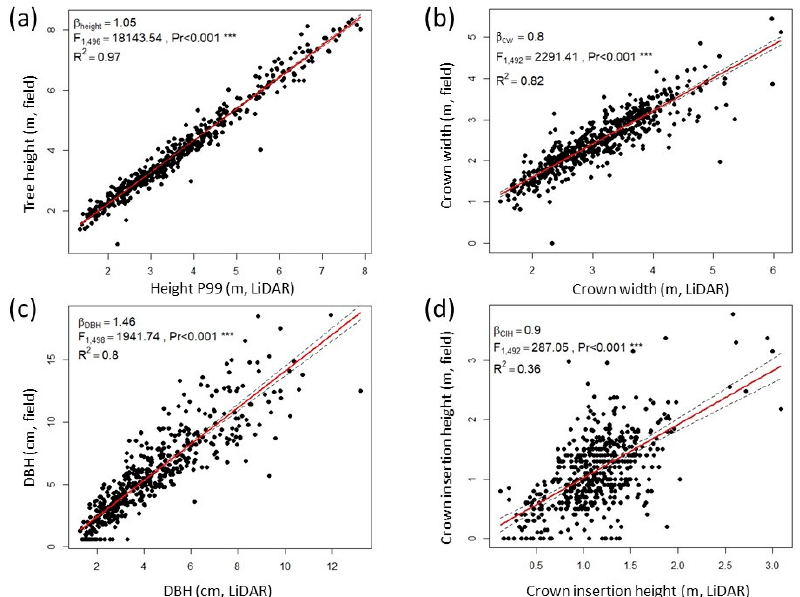
(Table 2). Eucalyptus tenuiramis tended to be taller, with greater above-ground biomass accumulation, and a more complex crown structure that was less dense than E. pauciflora (Table 2).